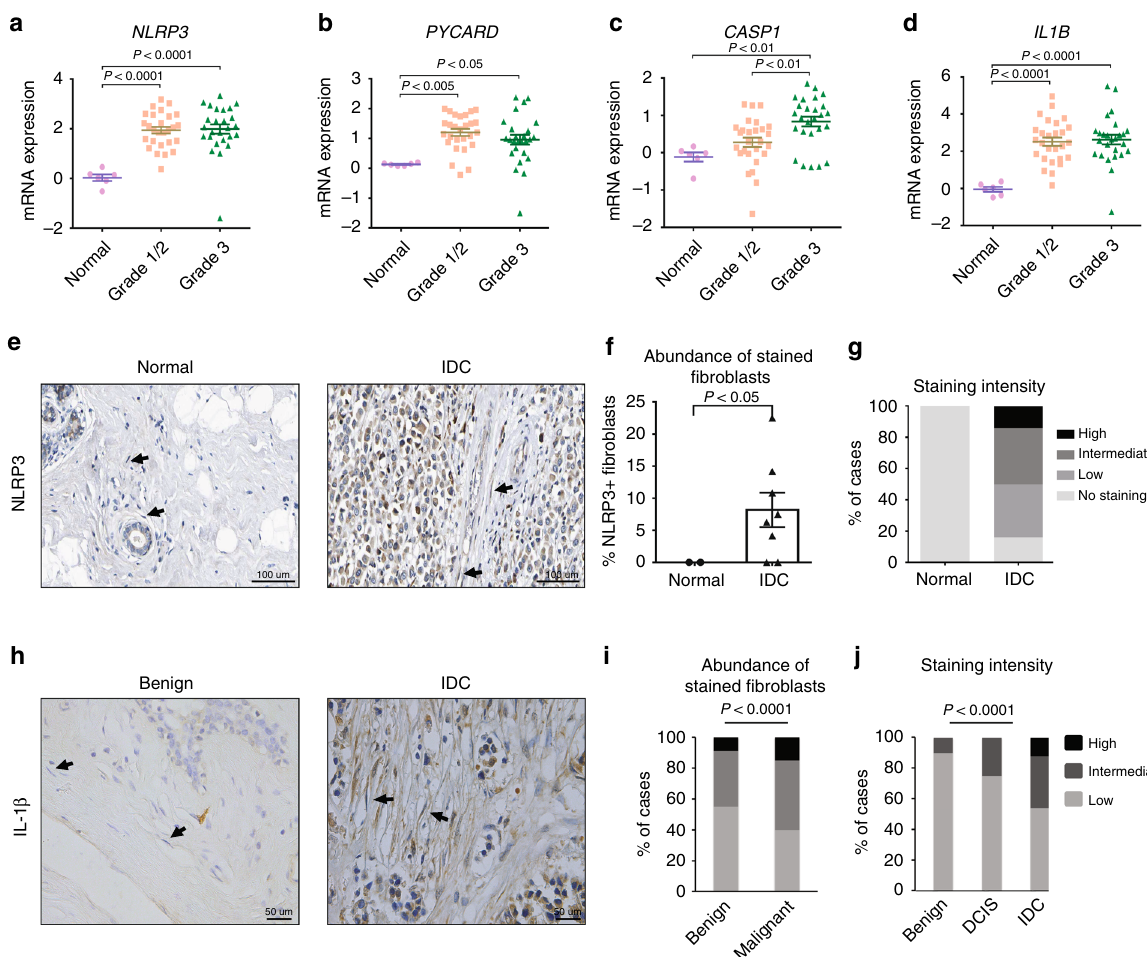
Fig. 2 The NLRP3 in fl ammasome pathway is up-regulated in CAFs in human breast tumours. a – d Expression levels of Nlrp3/Il1b pathway-related genes in tumour-associated stroma of breast cancer patients with in fi ltrating ductal carcinoma (IDC) staged 1/2 vs. 3 ( n = 53) or in normal breast stroma ( n = 6). Data was obtained from NCBI GEO (Dataset accession number GSE 9014) and is presented as mean ± s.e.m.; One-way analysis of variance test followed by Tukey ’ s multiple comparisons test. e – g Analysis of NLRP3 expression in fi broblasts in human IDC or in normal breast tissue sections. Images were obtained from the Human Protein Atlas. e Representative images, arrows in insets indicate fi broblasts. f Quanti fi cation of the percentage of NLRP3- expressing fi broblasts out of total fi broblasts for each sample. n = 2 samples for normal and 8 samples for IDC, error bars represent s.e.m; Welch ’ s t -test. g Quanti fi cation of staining intensity for NLRP3 in fi broblasts shown in e . h – j Staining for IL-1 β in benign or malignant (DCIS/IDC) tissue sections from human breast cancer patients. h Representative images of stained benign and IDC breast tissue sections. Arrows indicate fi broblasts. Scale bar, 50 µ m. i , j Quanti fi cation of the abundance i and staining intensity j of labelled fi broblasts, n = 73 (benign: n = 31, DCIS: n = 16, IDC: n = 26); Mann – Whitney test ( i ) or Kruskal – Wallis test followed by Dunn ’ s multiple comparisons test ( j ). Data are presented as mean ± s.e.m; Mann – Whitney test. Source data